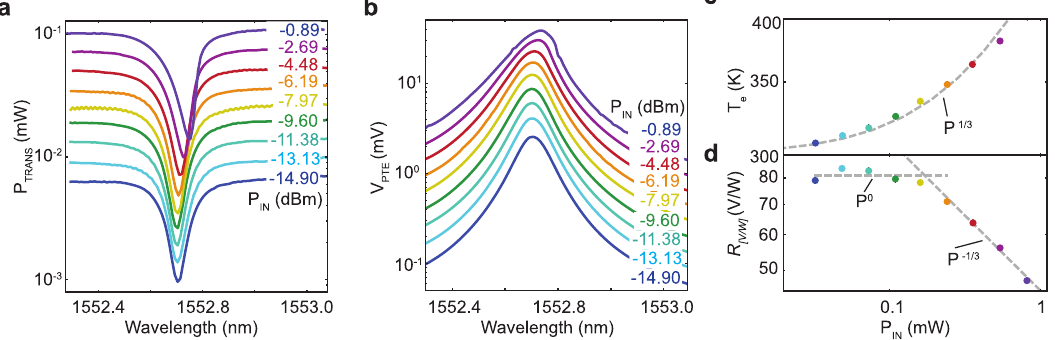
Fig. 5 Wavelength and power dependence. a Transmitted power for various P in . b Photovoltage for a fi xed gate voltage combination ( V G1 = 1 V, V G2 = − 1 V) for various input powers (same color code as for the transmission in a ). c T e calculated from the photoresponse in b and S in Fig. 4d. d Power-dependent R [V/W]